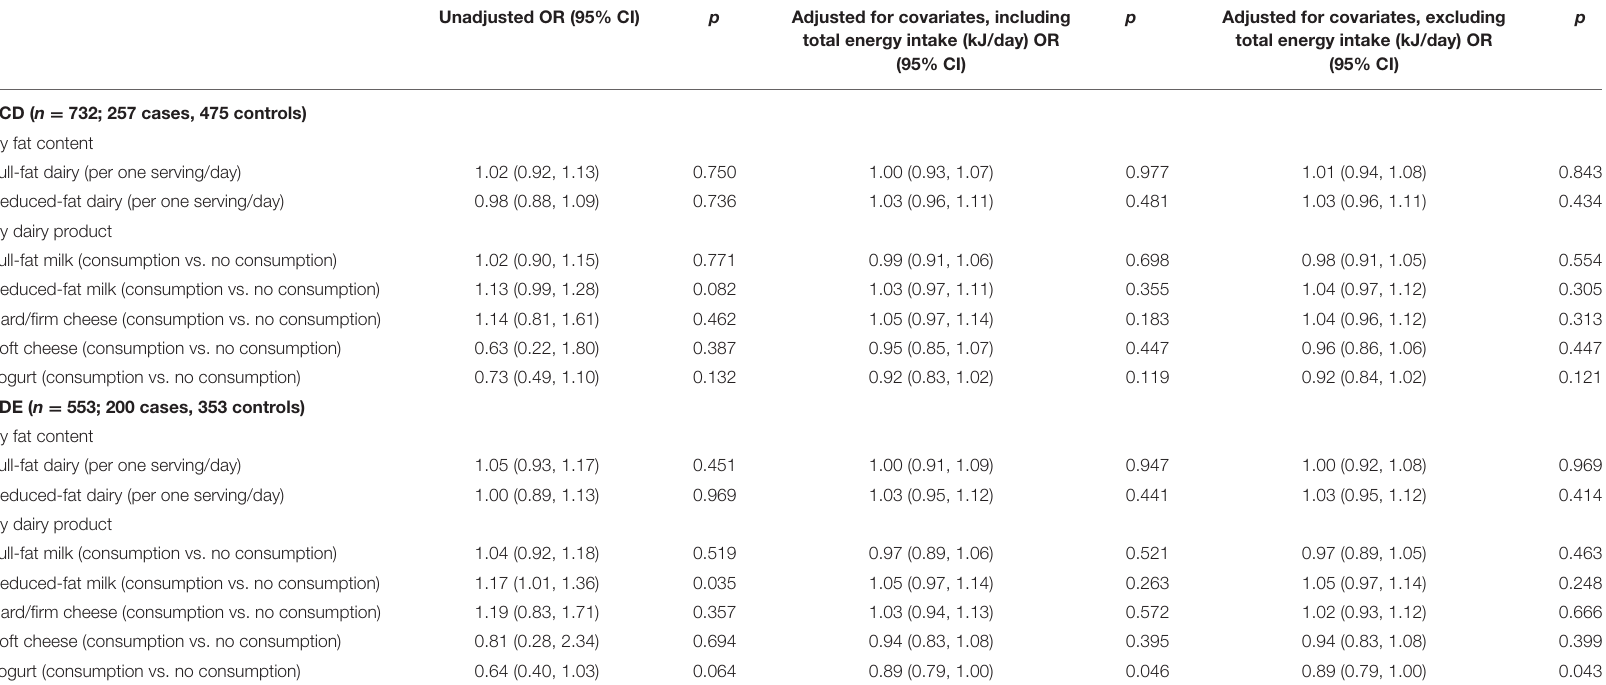
TABLE 3 | AIPW a models showing associations between the likelihood of FCD and FDE with full-fat dairy consumption, reduced-fat dairy consumption, full-fat milk, reduced-fat milk, hard/firm cheese, soft cheese and yogurt.